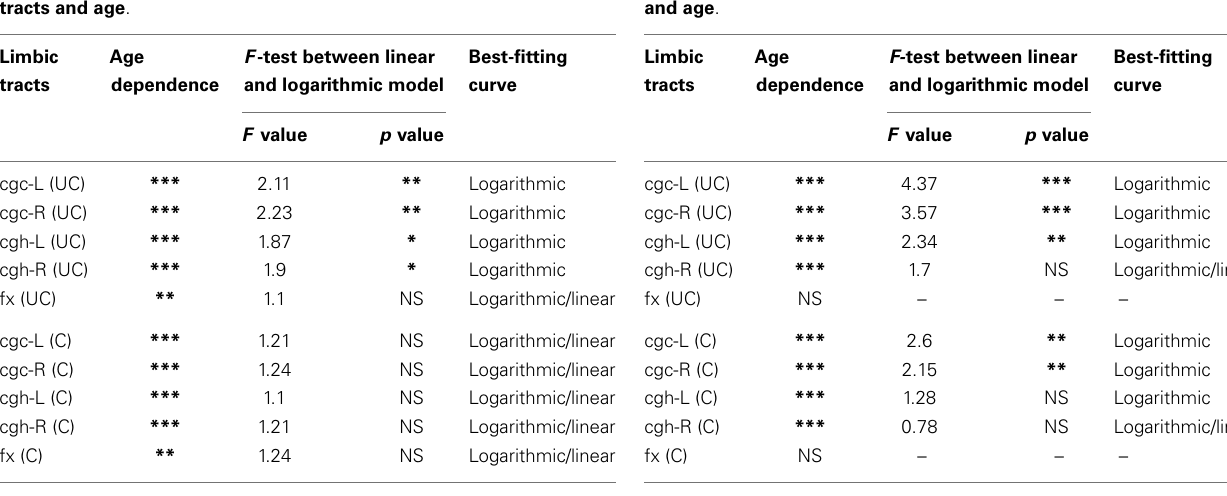
Table 1 | Relationship between fractional anisotropy (FA) of limbic tracts and age .